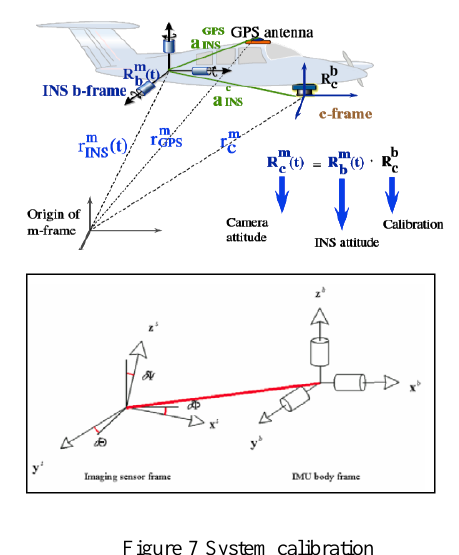
Figure 7 System calibration The lever arm between the GPS phase center and the IMU center is determined using a surveying process. The lever arm between the camera center and the IMU center is determined using a two-step procedure by comparing the output of conventional bundle adjustment and INS/GPS integrated POS solutions during the calibration process using: